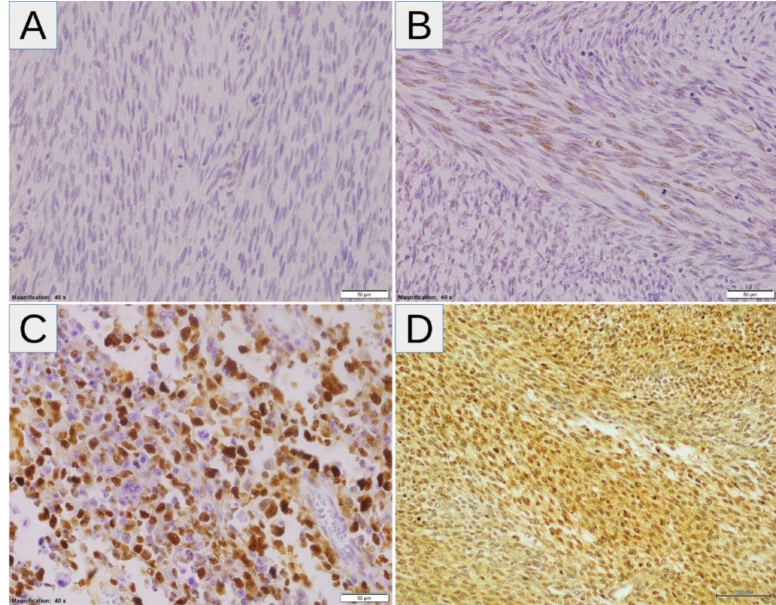
Figure 3. ( A – D ) Representative HIF1A staining patterns in MPNST: ( A , B ) Cases with absent ( A ) and low-intensity (1+) ( B ) nuclear expression of HIF1A (the expression coefficient—0, low-expression and 4, low-expression, respectively). ( C , D ) Cases with predominantly high-intensity (3+) nuclear ( C ) and nuclear/cytoplasmic ( D ) expression of HIF1A (the expression coefficient—12, high-expression in both cases). Abbreviations: HIF1A—hypoxia-inducible factor-1 α , MPNST—malignant peripheral nerve sheath